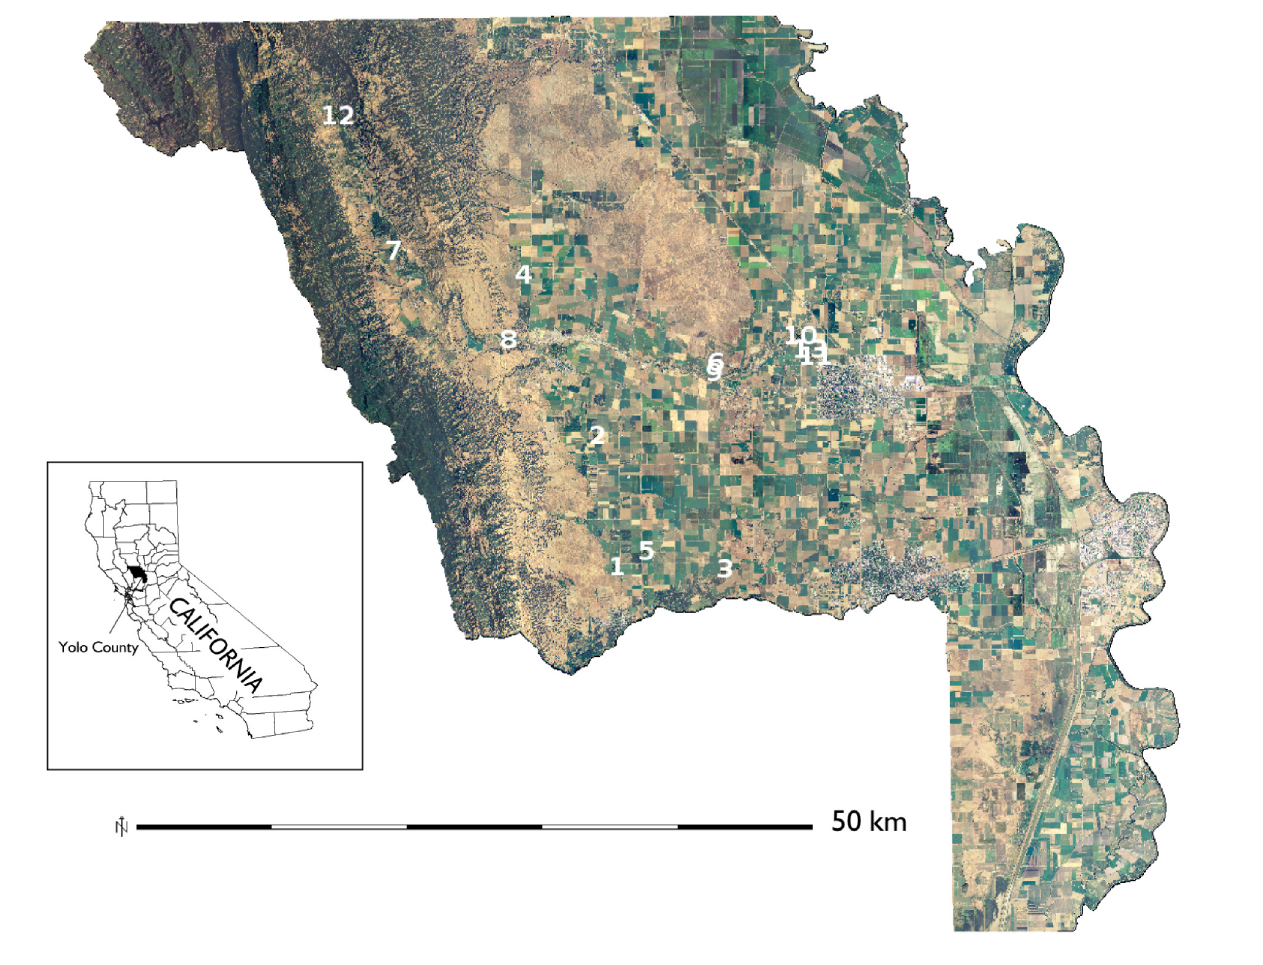
Fig 2. Map of the study sites. Locations of 13 organically-managed Roma-type tomato fields in Yolo Co., California, USA sampled over the 2011 growing season. Aerial imagery of the study area was derived from the National Agriculture Imagery Program (USDA-FSA-APFO NAIP).